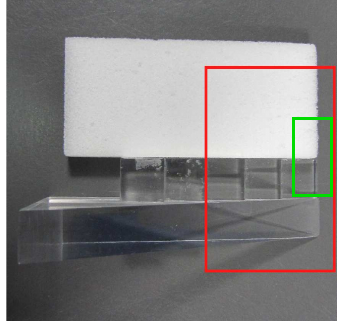
Figure 2. Photograph of the phantom. It consists of a synthetic sponge of constant thickness ( top ), a step wedge made from PMMA ( middle ) and a PMMA wedge with a constant slope ( bottom ). The red rectangle shows the area of the phantom that is imaged. The green rectangle marks the region that is imaged in the more detailed